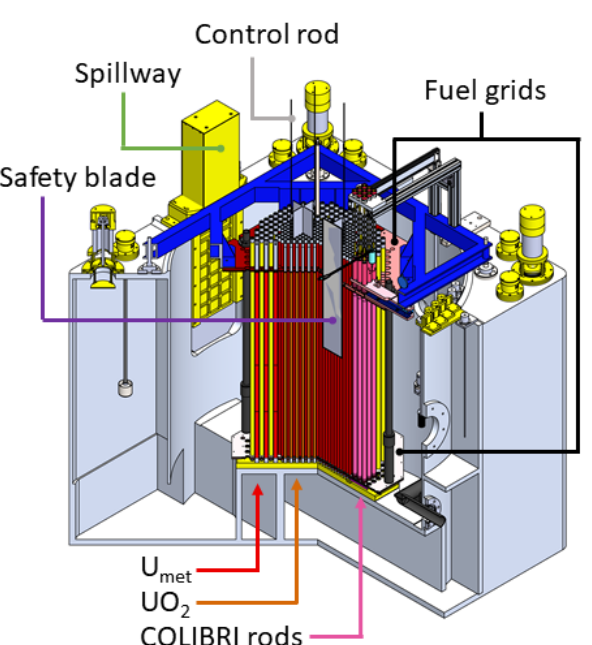
Fig. 1. 3D section of the CROCUS reactor model equipped with the COLIBRI fuel rod oscillator.